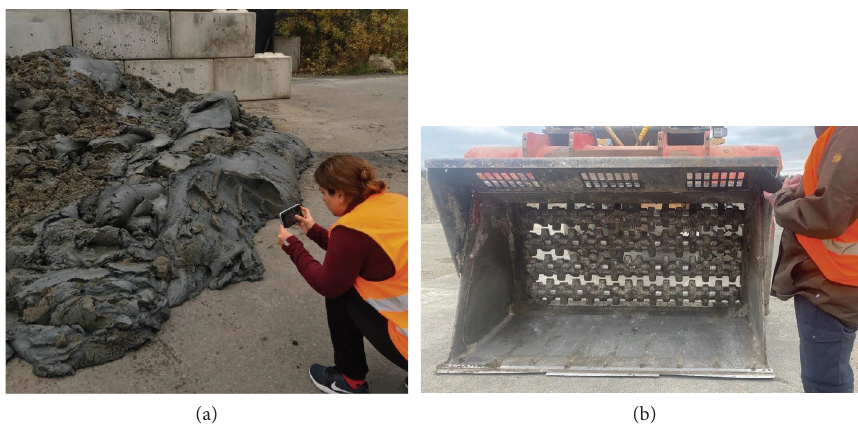
Figure 2: (a) Soil. (b) ALLU bucket